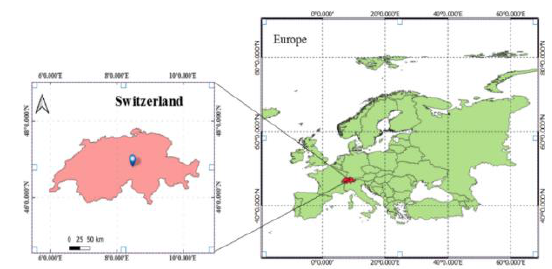
Figure 1 . A study area's location